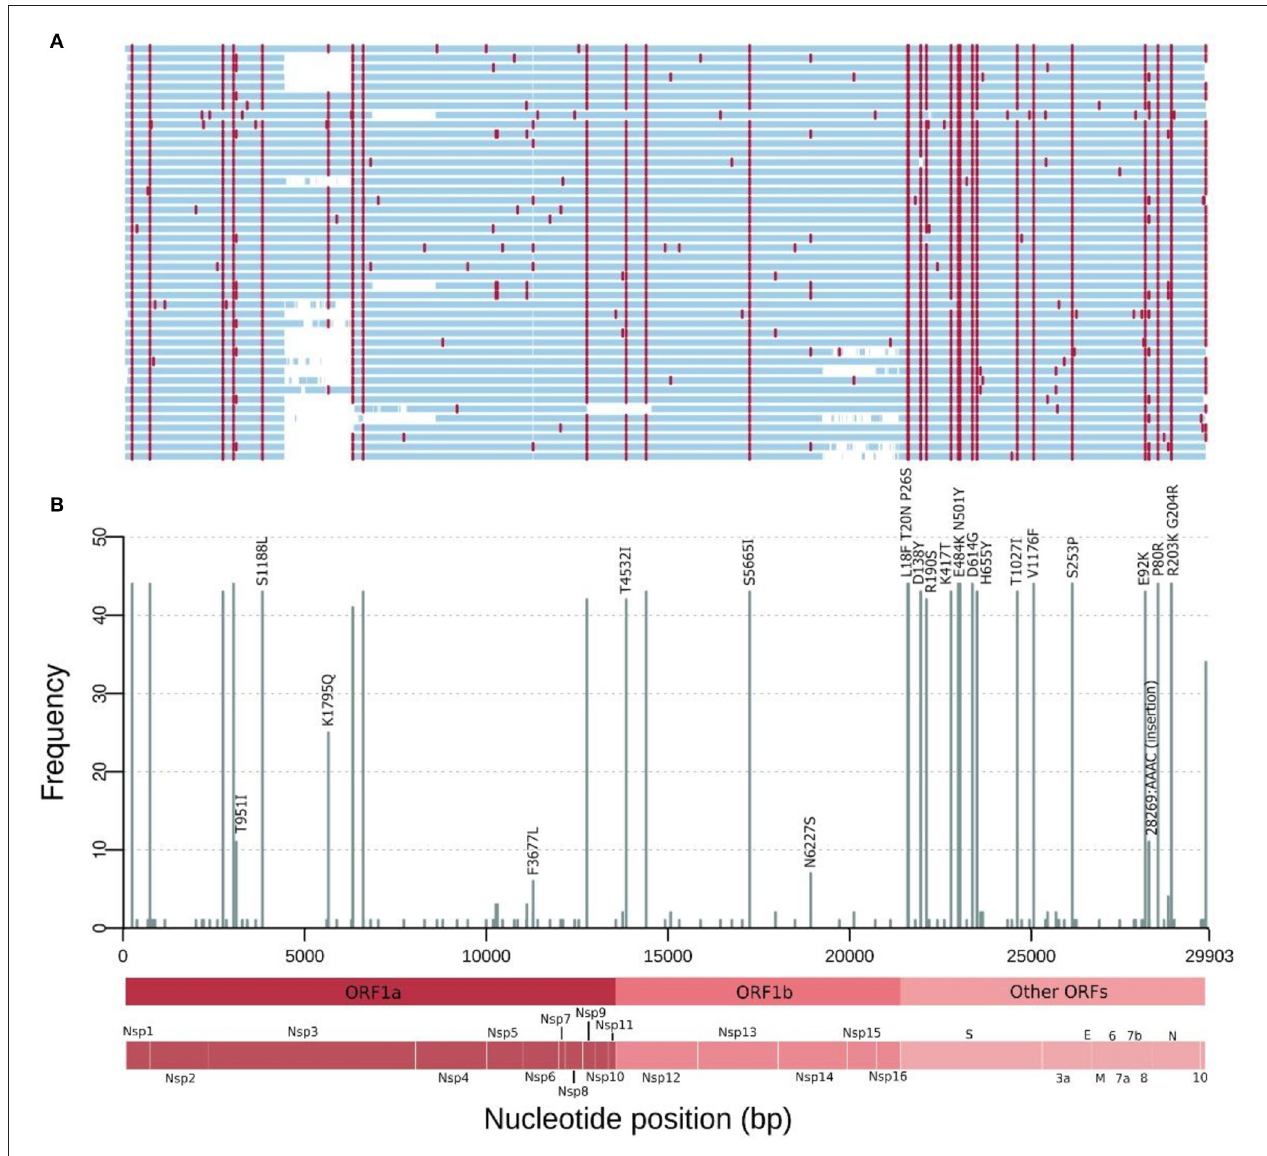
FIGURE 2 | Mutations of the SARS-CoV-2 genomes from the Amazonas state, Northern Brazil sampled in February and March 2021. (A) Genome map for the 44 genomes sequenced. Nucleotide substitutions are colored in red and blank regions represent low sequencing coverage. (B) Frequency of SNPs per SARS-CoV-2 genome position along the 44 genomes. These mutations are corresponding to the red lines in (A) and only missense substitutions represented by > 10 sequences have their respective amino acid changes indicated above the bars. Main Open Reading Frames (ORFs) and SARS-CoV-2 proteins are indicated at the bottom to allow a rapid visualization of the viral proteins